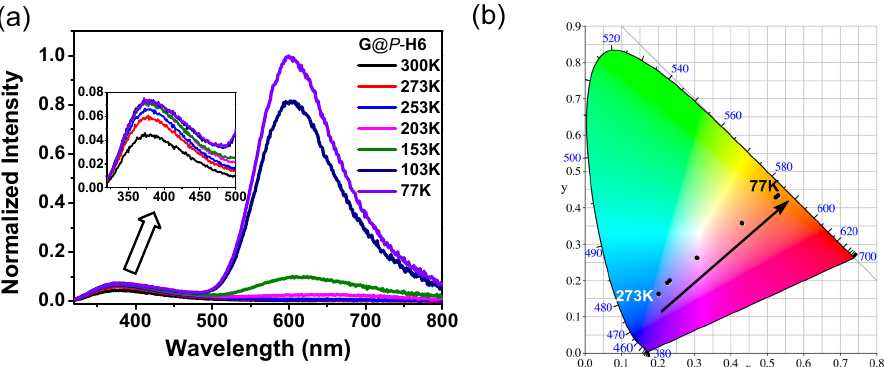
Figure 7. ( a ) Solid-state emission spectrum of G @ P - H6 at different temperatures and ( b ) CIE chro- maticity diagram showing the color coordinates of G @ P - H6 according to the temperature-dependent emission spectrum.